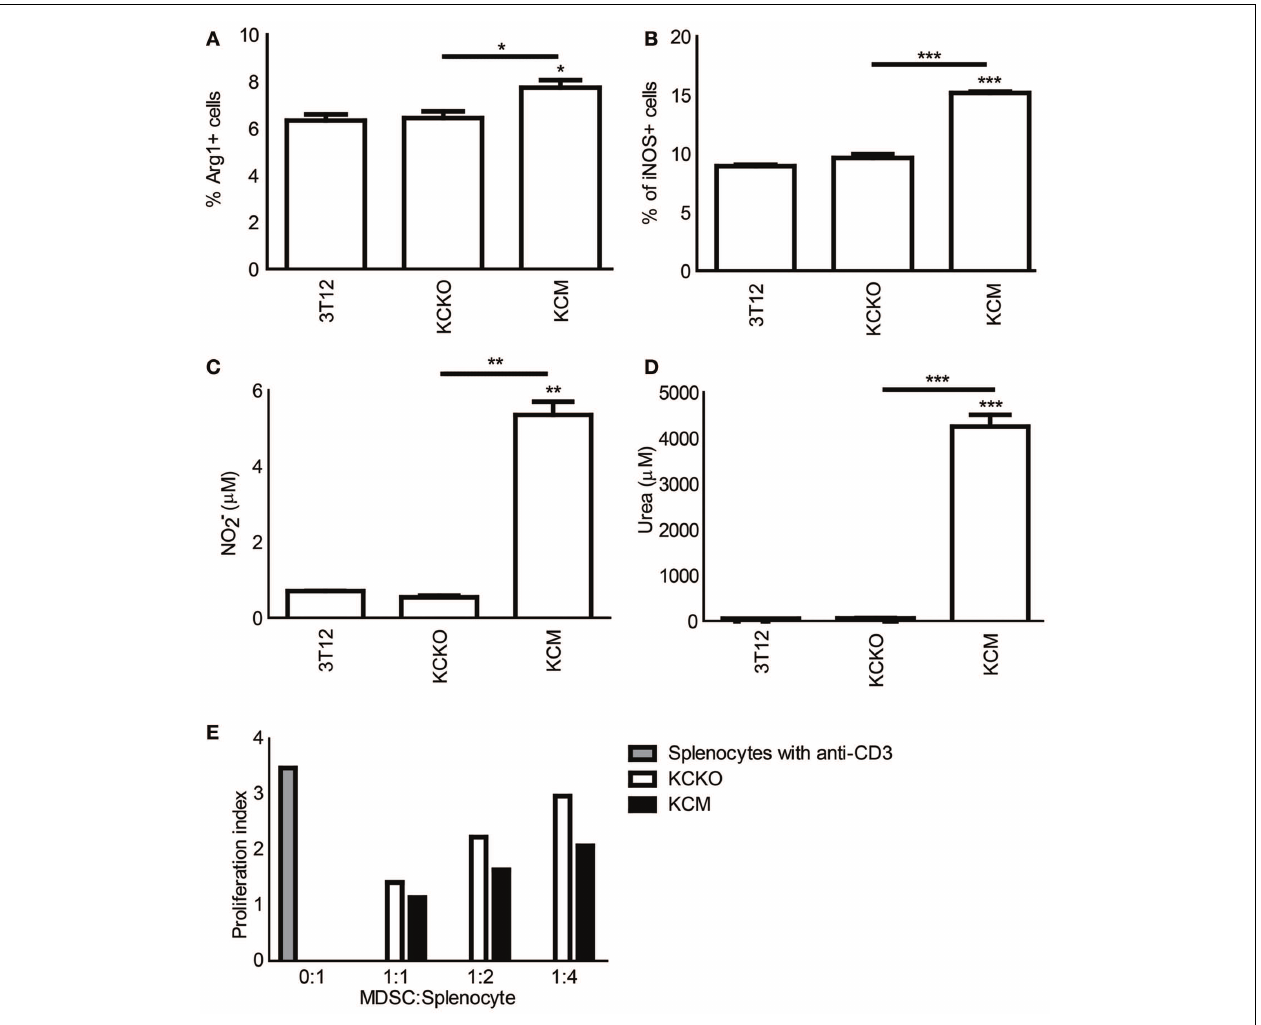
error are plotted. For (A,B) * p < 0.05, ** p < 0.01, and *** p < 0.001 for statistically significant differences from control (3T12) levels unless indicated by line above the bars; (E) CFSE labeled splenic cells were stimulated for 3days with anti-CD3 in the presence or absence of sorted Gr1 + cells at varying ratios from BM cultures of tumor-bearing mice to assess lymphocyte proliferation. Data is expressed in terms of proliferation index (all CSFE MFI were normalized to Day 0 CFSE fluorescence of splenocytes). Data is representative of one of three experiments. Due to technical issues, there were no biological replicates for this experiment and hence a two-way ANOVA could not be performed. However, a paired t-test was conducted between KCKO and KCM MFI values for equivalent dilutions.The difference was found to be significant ( p ≤ 0.05) at each dilution (not